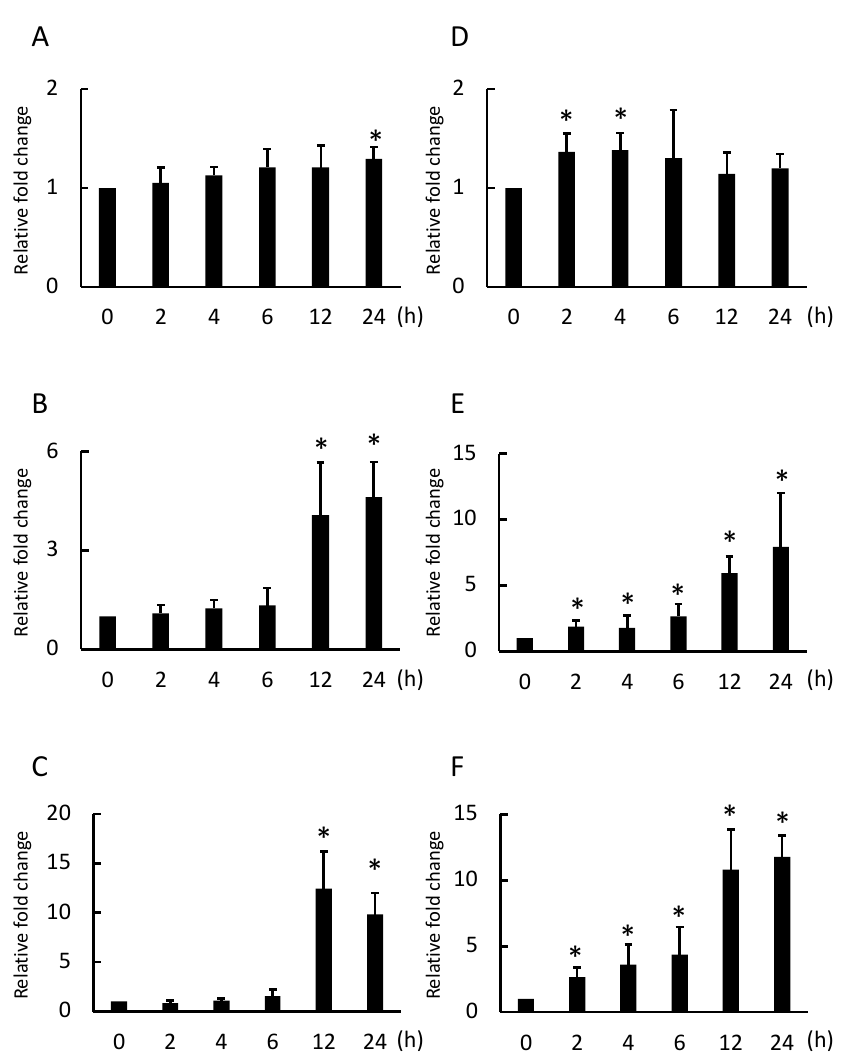
Figure 1. Expression levels of IL-1 β , IL-6 and IL-8 mRNA were measured by quantitative polymerase chain reaction (qPCR), after incubation with 10 µ g/mL nanotitania ( A – C ) or 100 µ g/mL nanotitania ( D – F ). ( A , D ) IL-1 β , ( B , E ) IL-6 and ( C , F ) IL-8 mRNA expression. Each data point indicates the average of six gene expression quantification results (n = 6). Bars indicate standard deviation, and asterisks indicate p < 0.05 compared with controls.